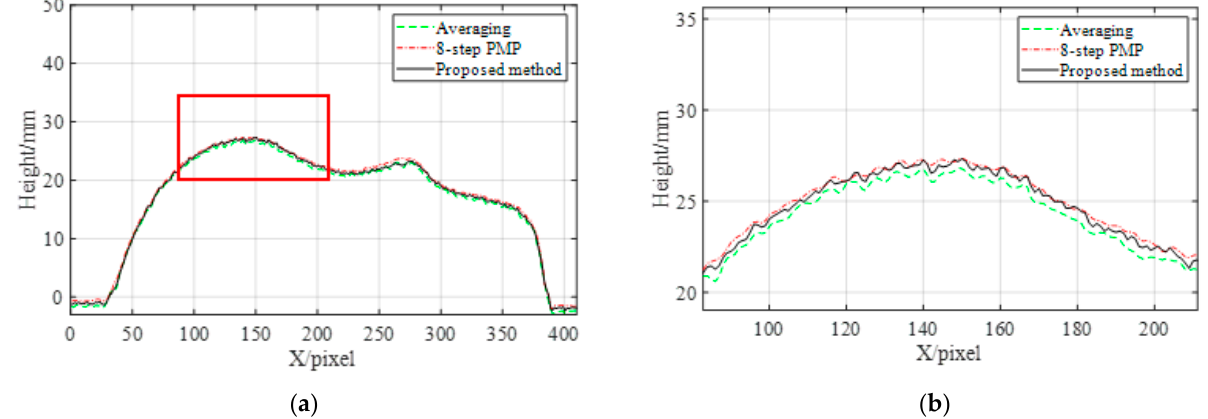
Figure 7. The 255th column data of the reconstructed object: ( a ) Sectional view of the 3D profile of the object; ( b ) Magnified view of the forehead area.